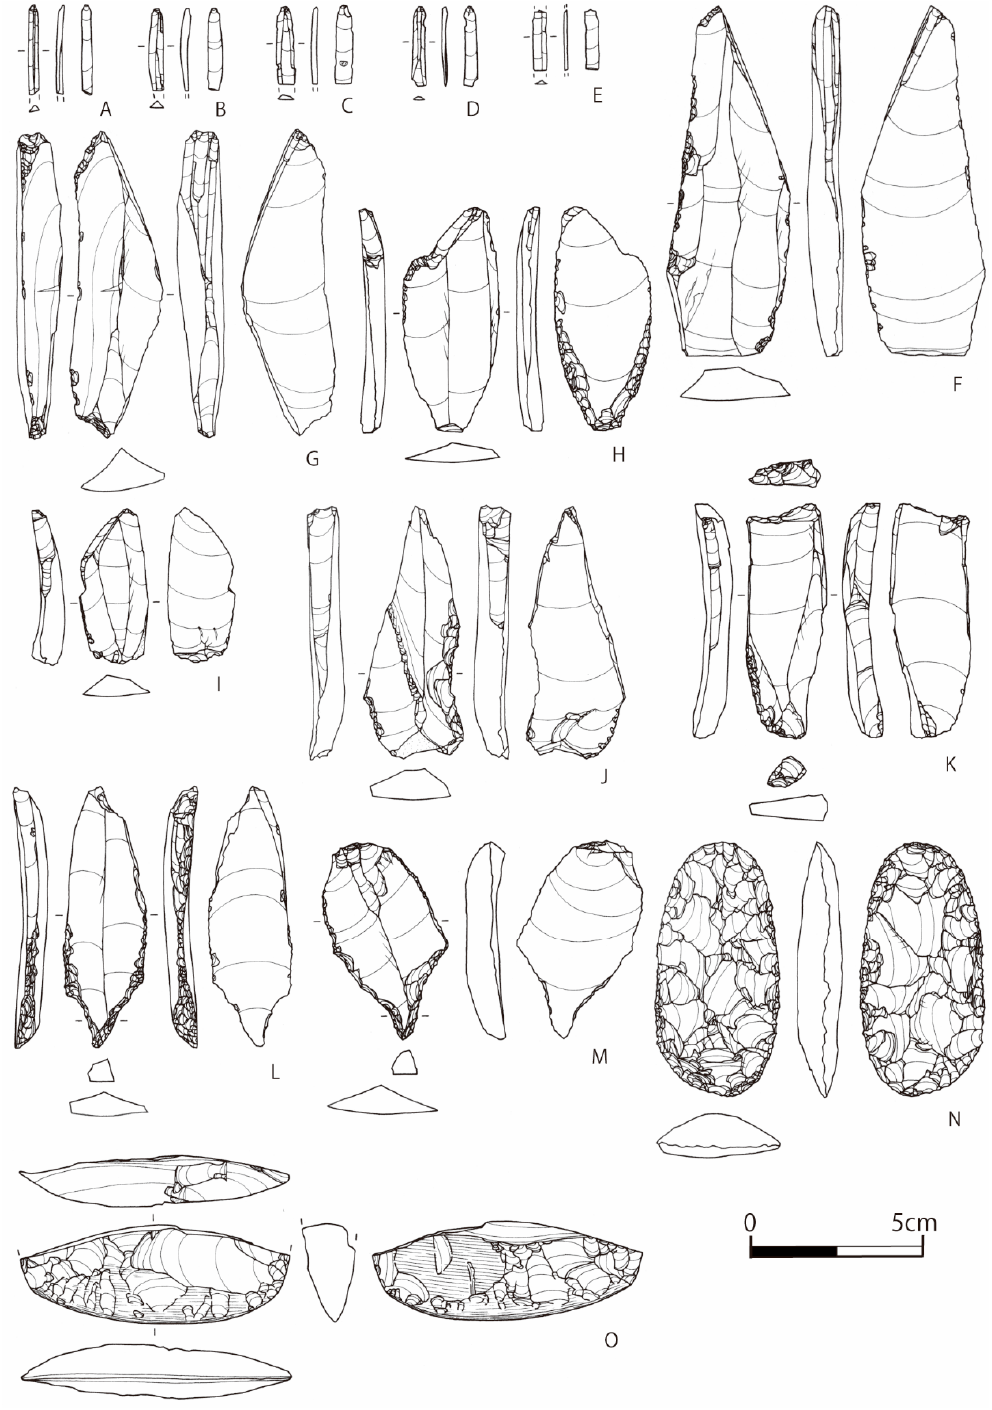
Figure 2. Stone artefacts in the Hirosato techno-complex. Examples from the Ankaritou-7 site in central Hokkaido: ( A–E ) microblades; ( F , G ) Hirosato-type microblade cores; ( H–K ) burins; ( L , M ) drills; ( N ) bifacial tool; ( O ) broken edge-ground stone axe. Reproduced from [55].